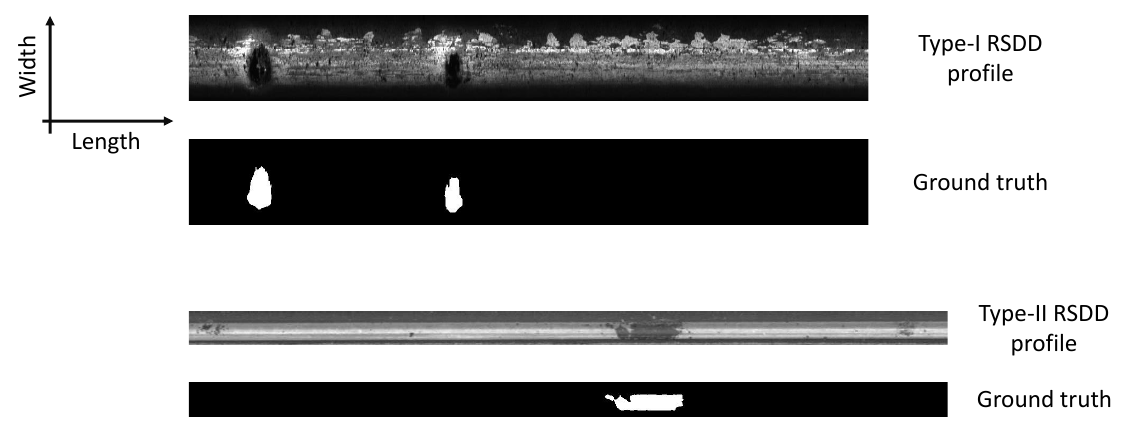
Figure 1. Representative railhead profiles and corresponding ground truth images (data value, black: 0; white: 255). RSDD, rail surface discrete defects